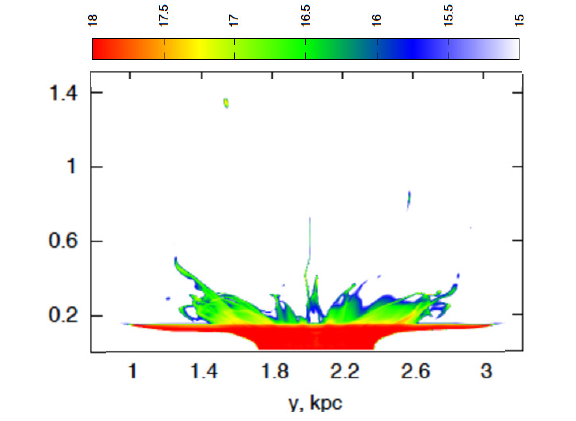
Figure 5. HI distribution in an expanding superbubble in the model shown in Figure 4 at the age 4 Myr (the central region is zoomed in to compare to Figure 4), color bar shows HI column density from N HI = 15 to 18 cm − 2 . (From log 10